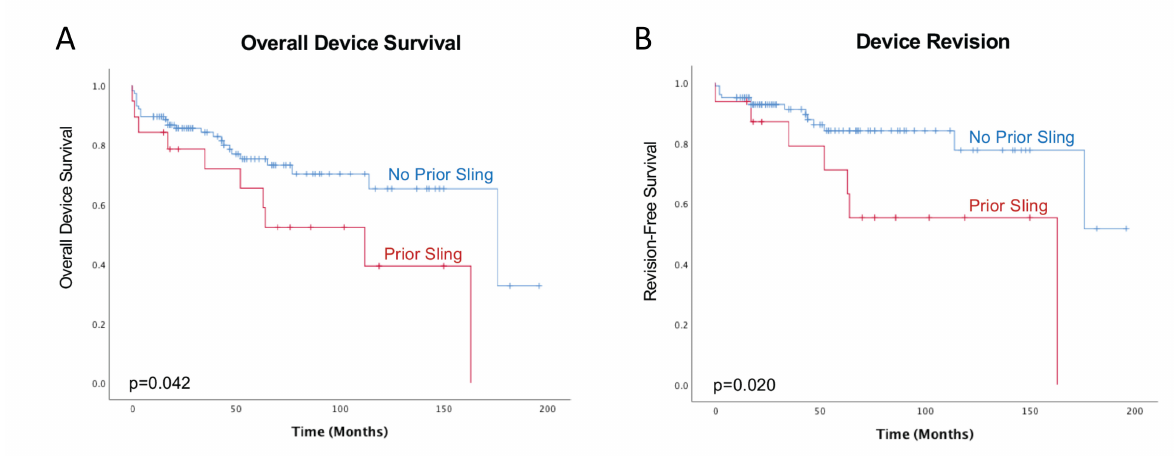
Figure 1. Kaplan-Meier analyses: Presence of a prior sling significantly decreases AUS survival postoperatively, both overall (need for reoperation for any cause, log rank p = 0.042, panel ( A )) and until a revision was needed for insufficient continence (log rank p = 0.02, Panel ( B